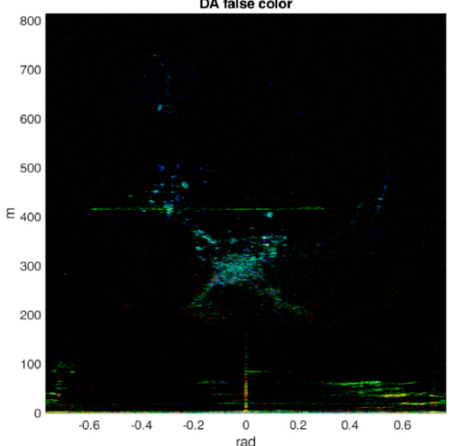
Figure 15. DA false colour map code: Red = RR, Green = RL, blue = VV.